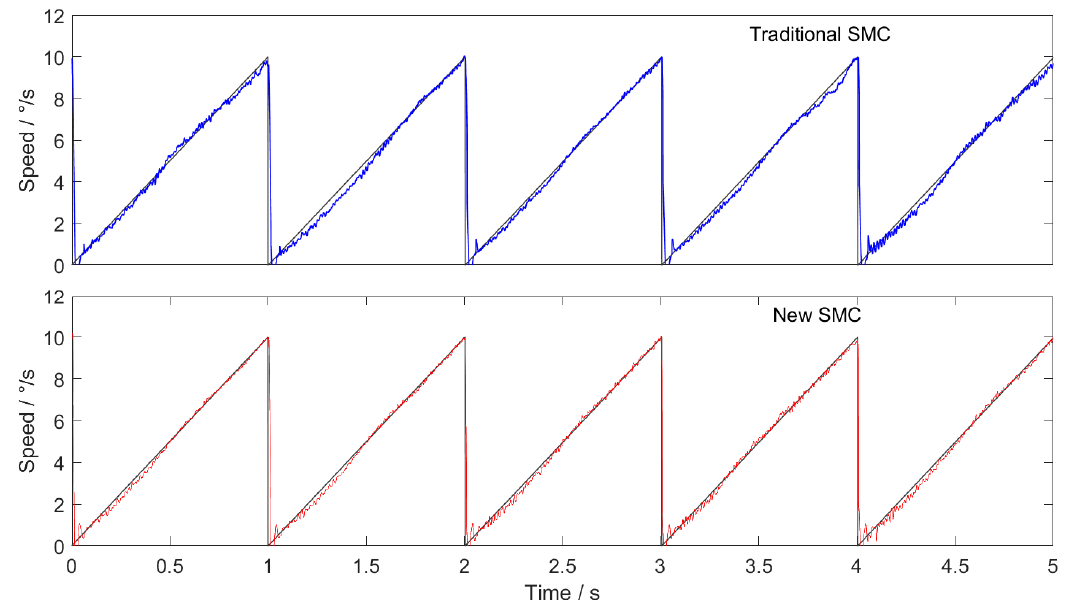
Figure 9. Tracking curve of triangular wave.